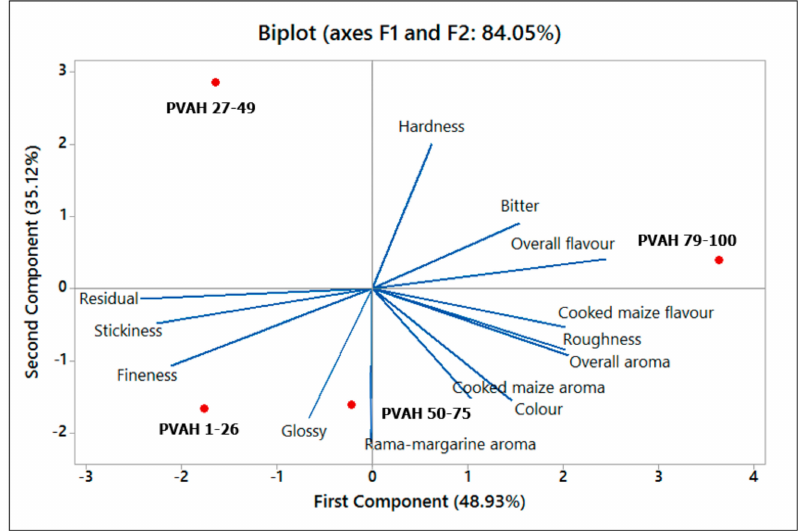
Figure 2. Biplot of principal component PC1 versus PC2 loadings for four provitamin A-biofortified maize sti ff porridges. PVAH = Provitamin A